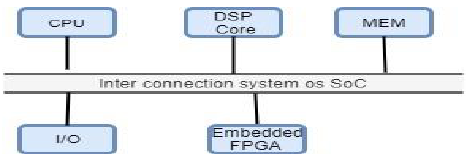
Fig (1). Interconnection System of SoC NoC is a communication network between multiple devices. Devices are connected in regular or irregular topology [7-9]. The devices are processor, memory, DSP core etc are called processing element (PE). The PE has two types, homogeneous and heterogeneous. Fig (2) shows 4*4 mesh topology of NoC. In which PEs are connected to local routers through a network interface (NI) and routers are connected to each other with a point to point connection. The NI transforms the message to packet and packet received by router send it to neighbour router. The packet move to the destination is travelling through routers [10,